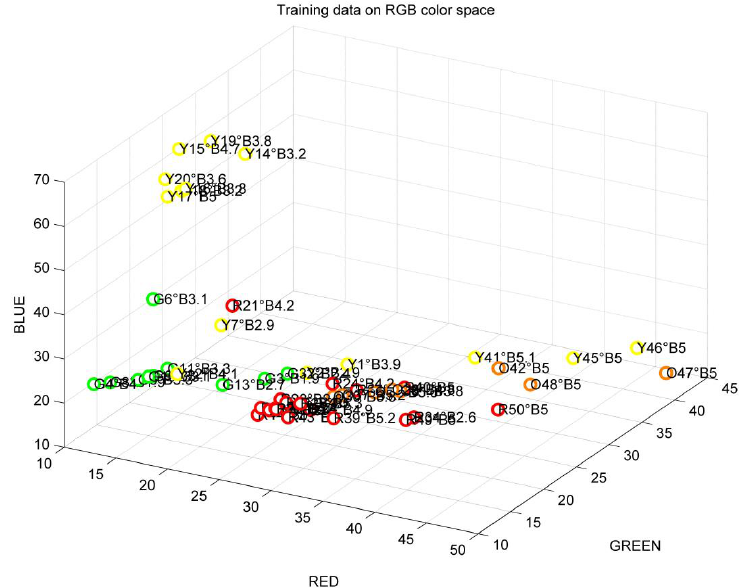
Figure 5. Mapping averages of the red, green, blue (RGB) channels for four classes of bell peppers.